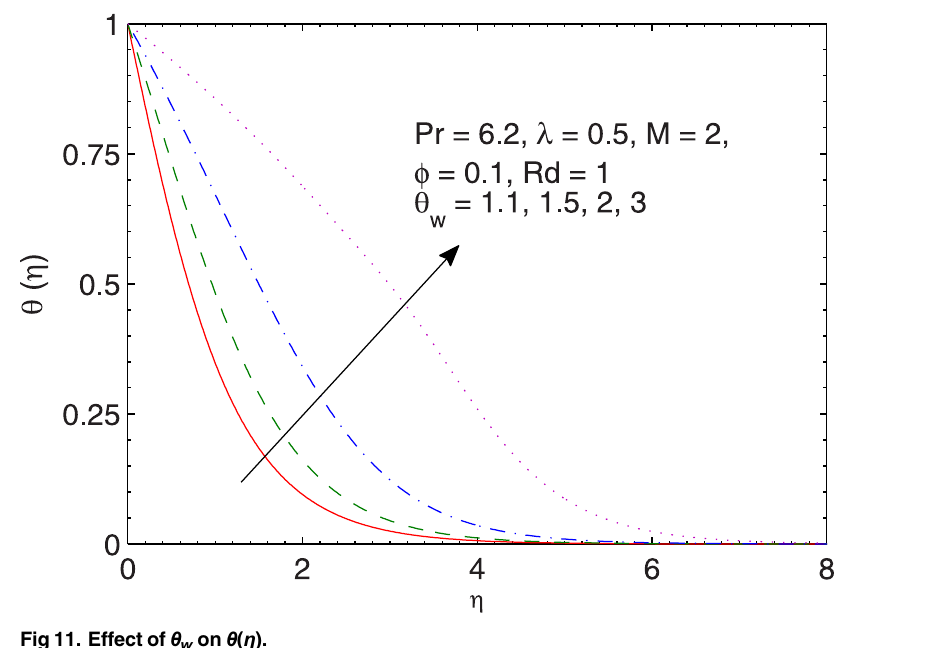
Fig 11. Effect of θ w on θ ( η ). doi:10.1371/journal.pone.0149304.g011 p ffiffiffiffiffiffiffi = Nu Re x x Nusselt number Nu